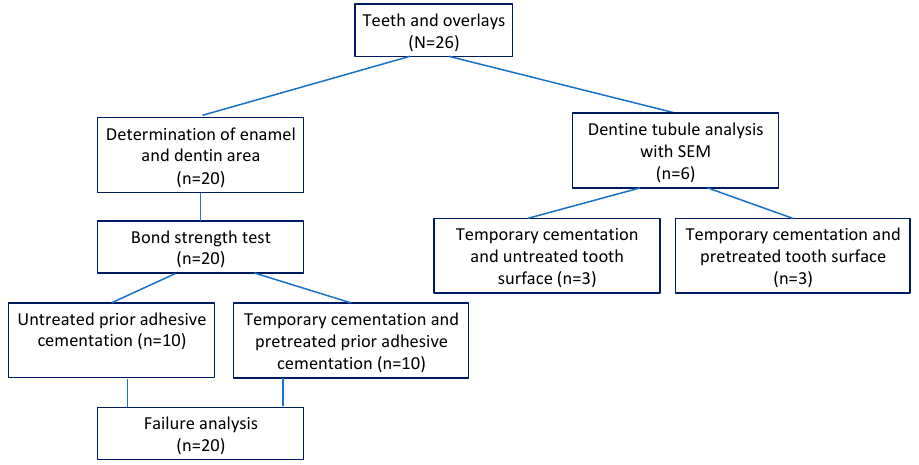
Figure 1. A flow chart of the study experimental design.